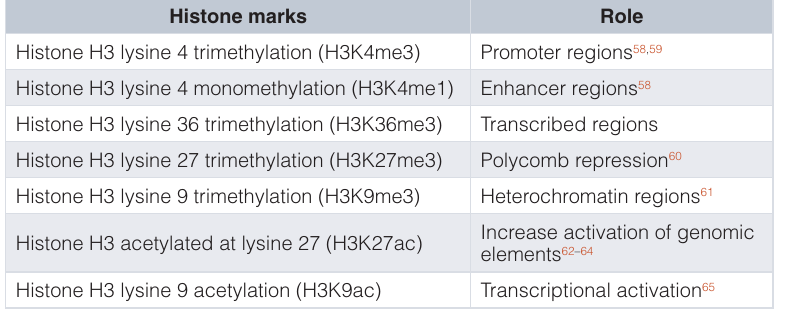
Table 4. Histone marks that define genomic elements.